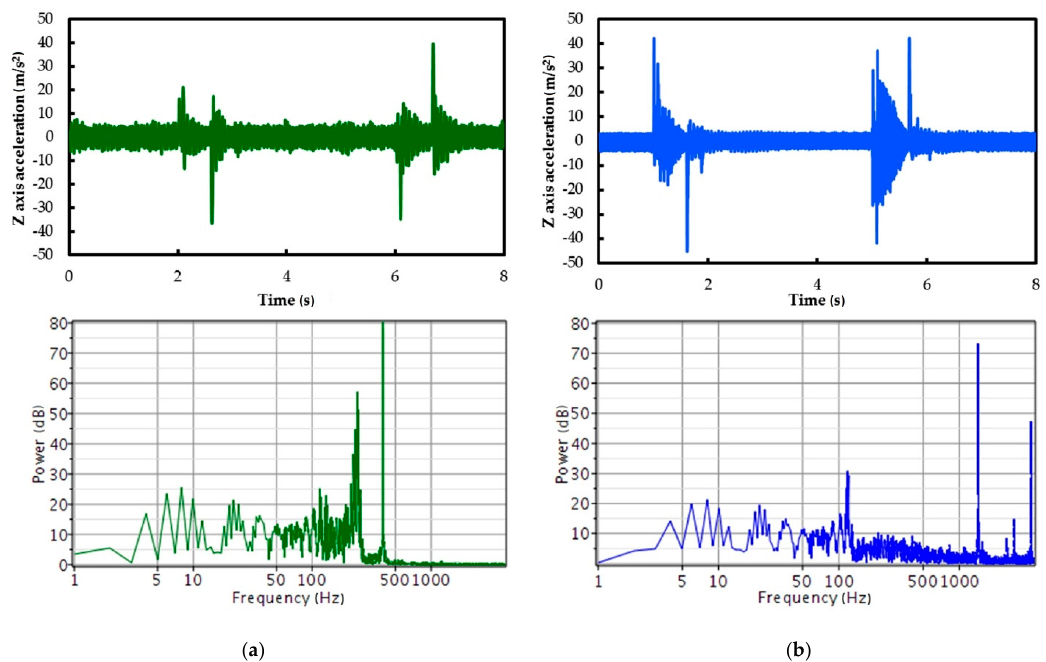
Figure 19. Z axis acceleration records and power spectrum; ( a ) simulation model; ( b ) experimental records.